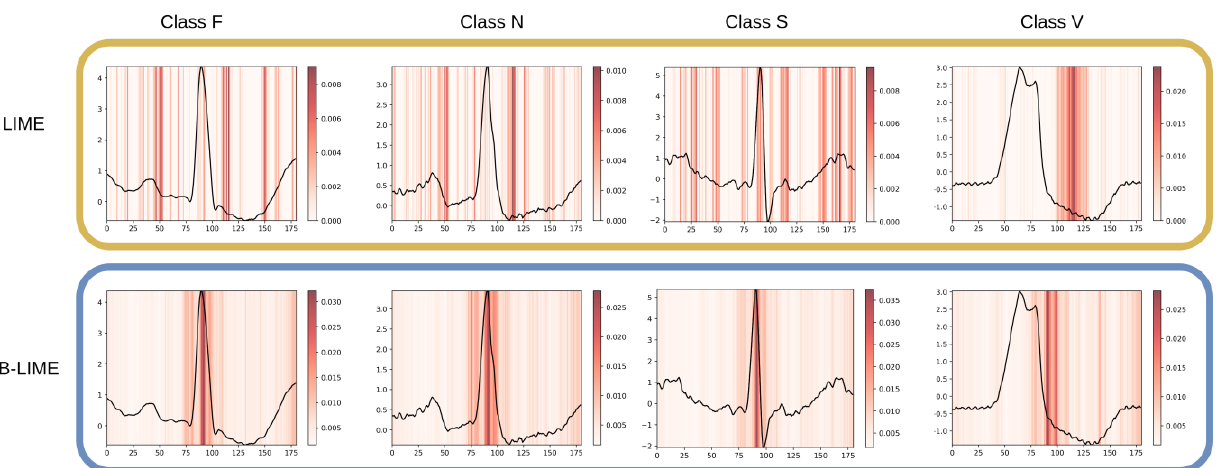
Figure 8. Comparison between LIME and B-LIME explanations in different classes.